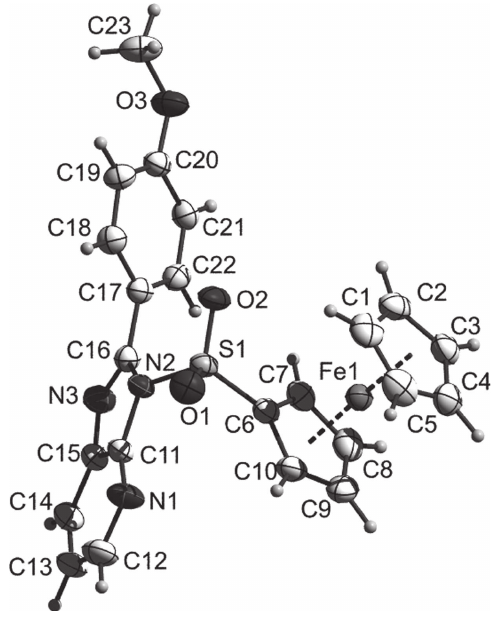
Table 1: Data collection and handling.